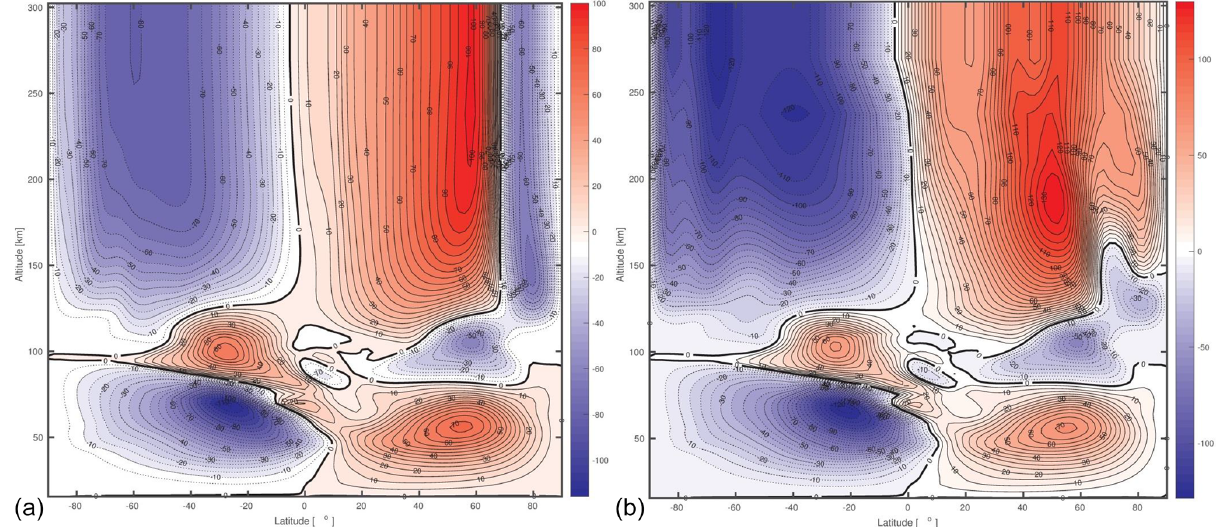
Figure 11. CMAT2 zonally averaged zonal winds for 00:00UT at the December solstice 2008 (solar minimum conditions) to demonstrate the effect of drastically reducing the molecular viscosity in order to raise the altitude where winds become independent of altitude. Panel (a) shows isobars for a standard simulation, whereas panel (b) represents a simulation where the molecular viscosity is 100 times smaller (from Hood,